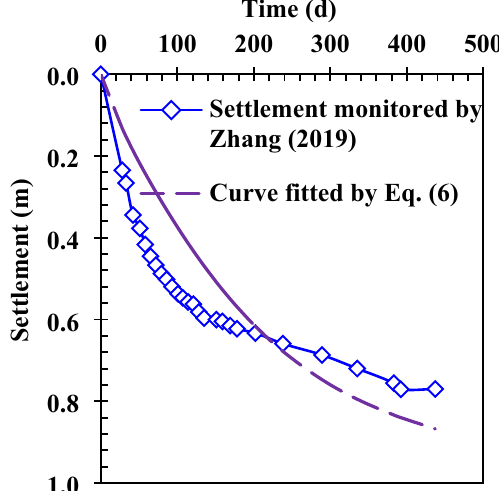
Figure 4. Settlement of newly filled MSW layer varies with